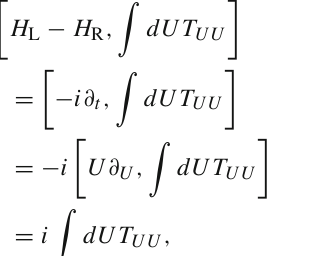
Fig. 20 A schematic construction of the traversable wormhole. The blue lines represent the stress-tensor inserted on both boundaries at some time t = t 0 , the green arrow represent a signal that is emitted at a sufficientlypastontheleftboundaryandreaches,duetotheshiftcaused by the T UU back-reaction, the right boundary at a sufficient